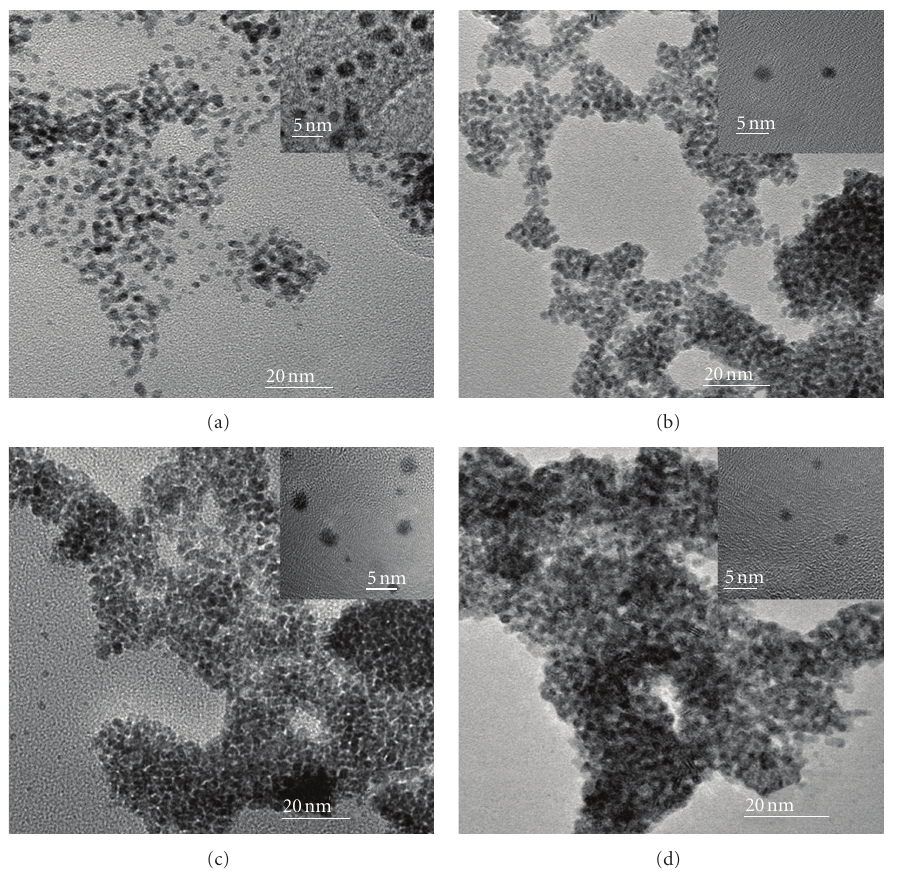
Figure 1: The TEM images of pure Pt (a) and bimetallic PtRu (b), PtAu (c) and PtIr (d) nanoparticles. were well indexed to Pt (JCPDS No. 87-0640, a = b = c